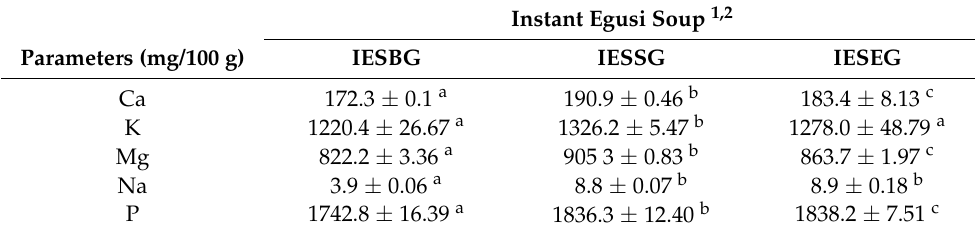
Table 7. Major mineral composition of instant egusi